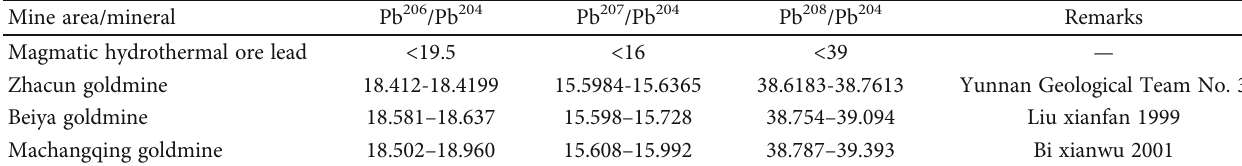
Table 2: Composition of the lead isotopes in Zhacun Village, Beiya and Machangqing goldmine areas. Mine area/mineral